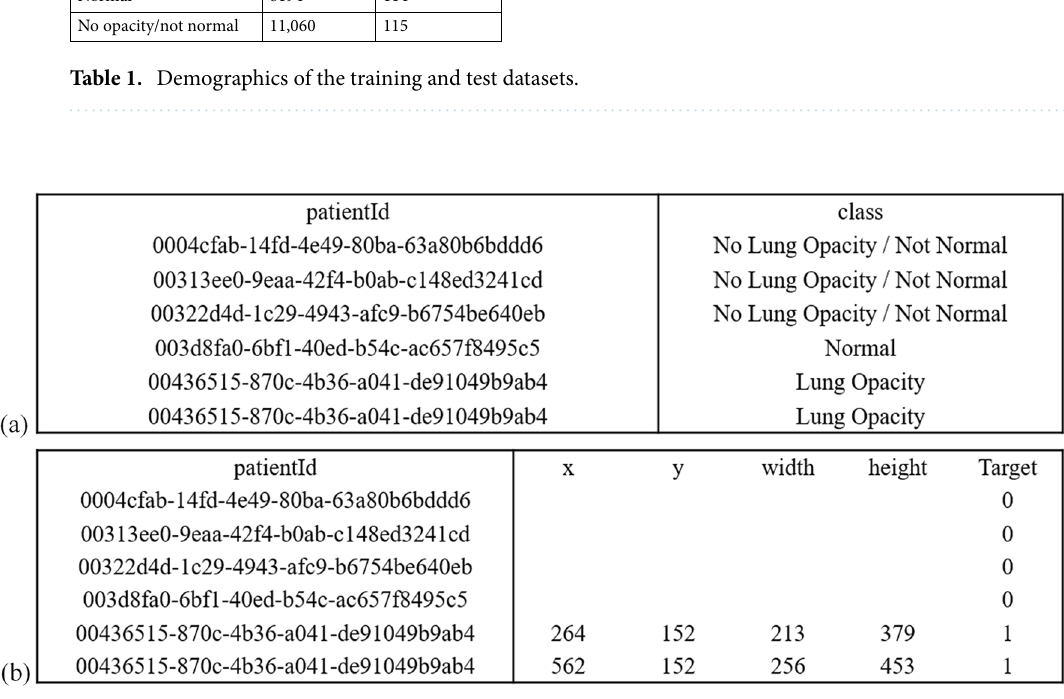
Figure 1. Five example images in the RSNA dataset. Details of ( a ) class information and ( b ) corresponding lung-opacity region. The coordinates, width, and height of a bounding box for each